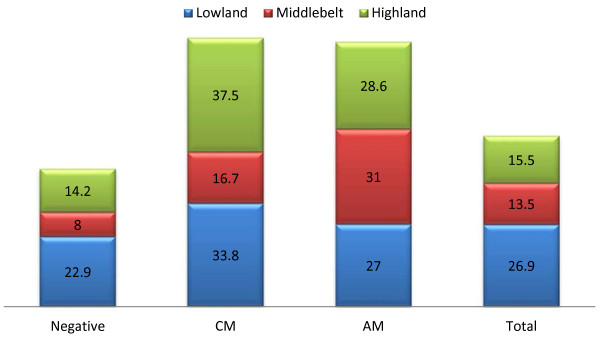
Prevalence of anaemia as affected by clinical status and altitude.